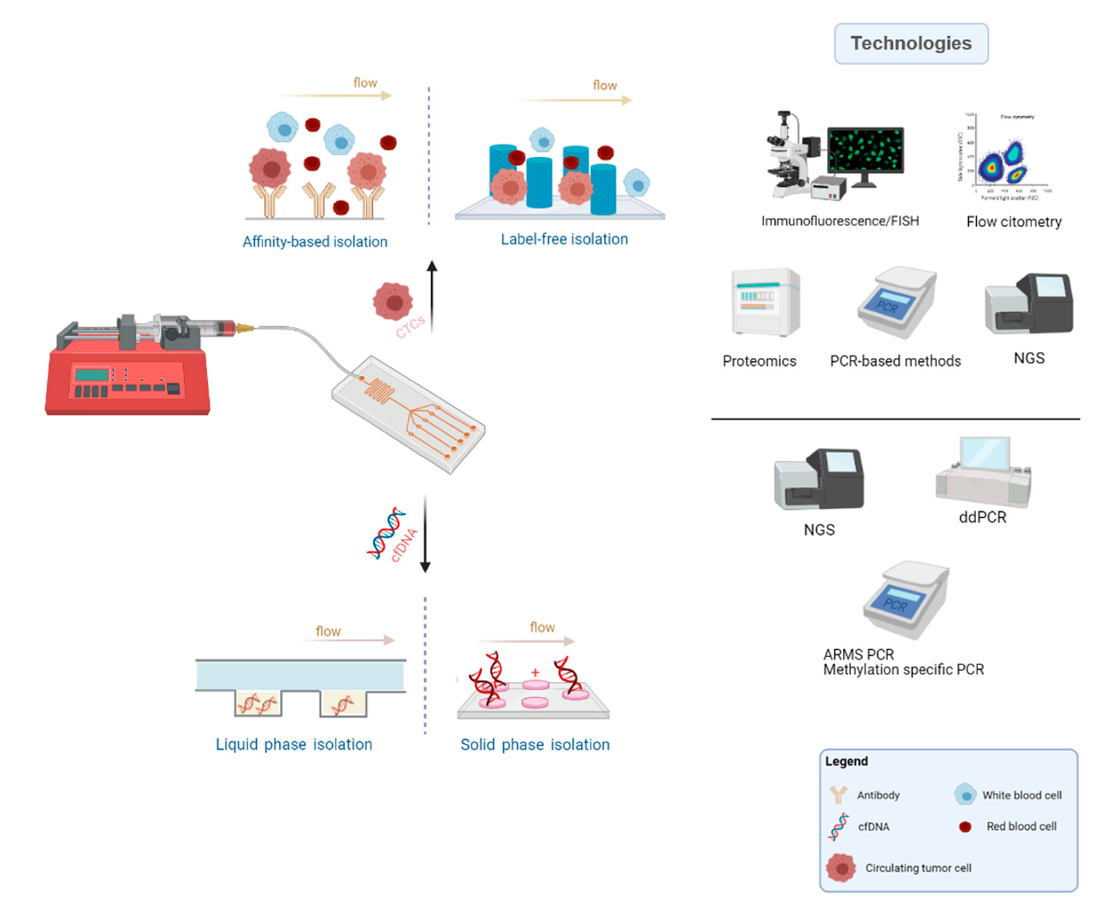
Figure 2. Common microfluidics methodology, main principles applied for CTCs and cfDNA isolation and typical technologies used for the biomarkers characterization (Created with BioRender.com).